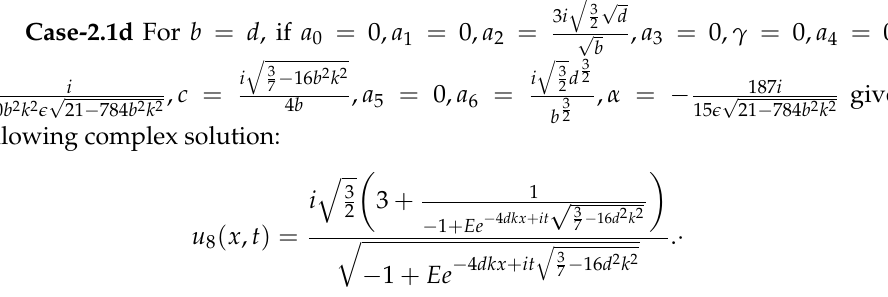
Figure 13. The contour figures of Equation